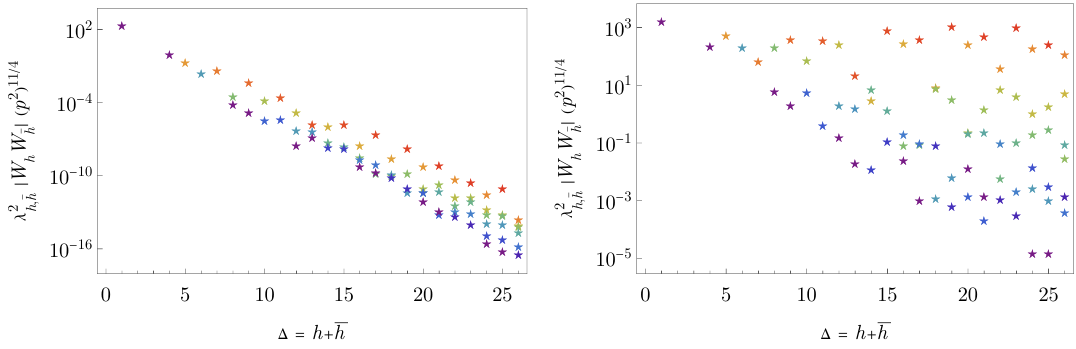
(cid:27)(cid:27)(cid:27)(cid:27) in the h i